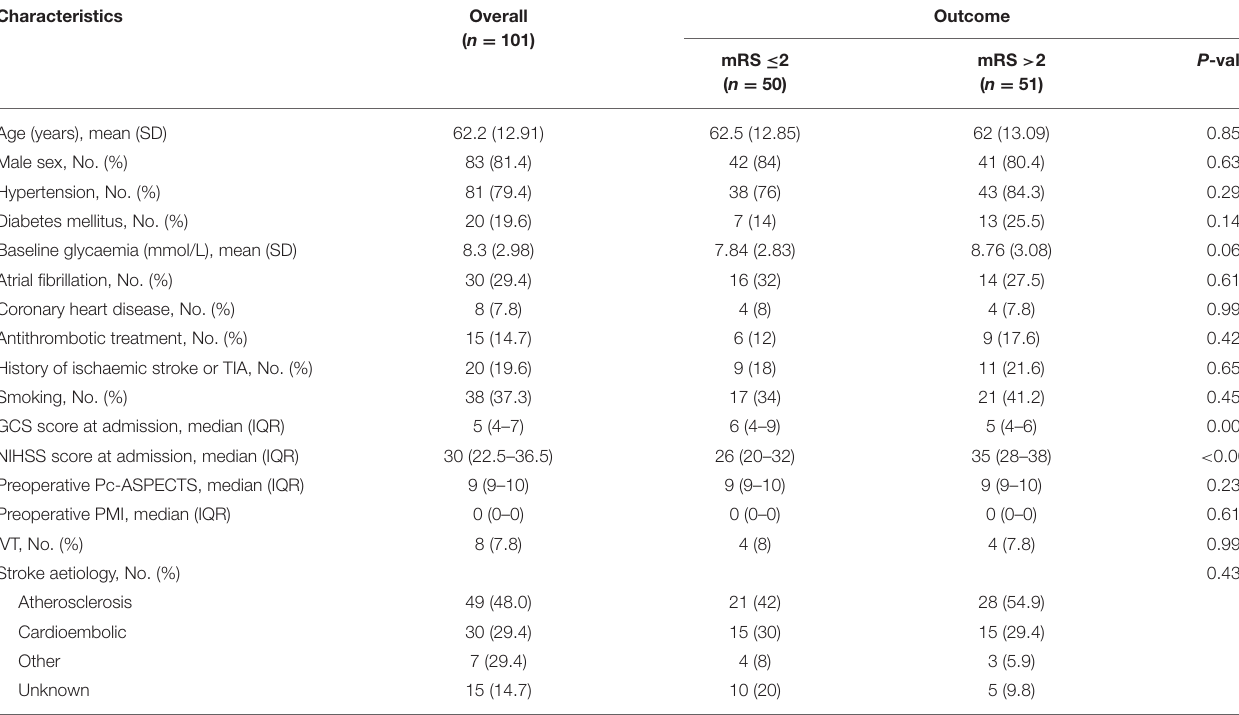
TABLE 1 | Baseline characteristics and functional outcome (mRS ≤ 2 vs. mRS >